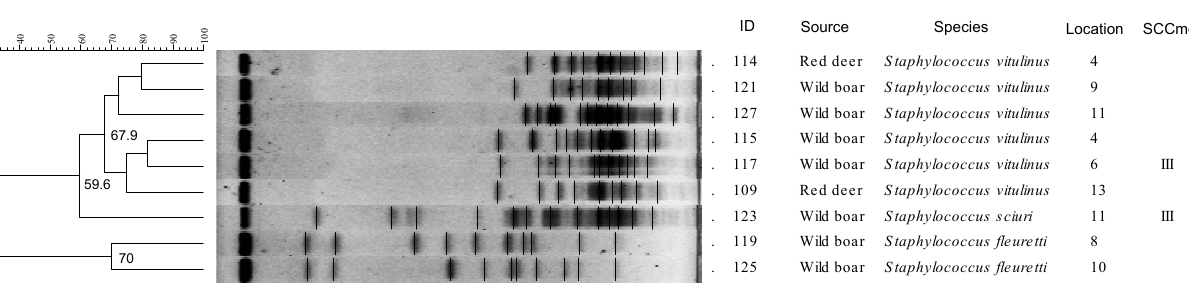
Figure 2. Dendogram based on PFGE macrorestriction pattern of mecA -positive Staphyloccus isolates. Dendogram showing 9 different profiles further divided into three clusters corresponding to the three staphylococcus species. The scale at the top indicates the similarity indices (in percentages). Isolate nº 102 (SCC mec type III) was non-typeable. On the other hand, a total of nine different macrorestriction profiles and one non- typeable sample (102) were obtained in the 10 isolates processed by PFGE (Figure 2). The